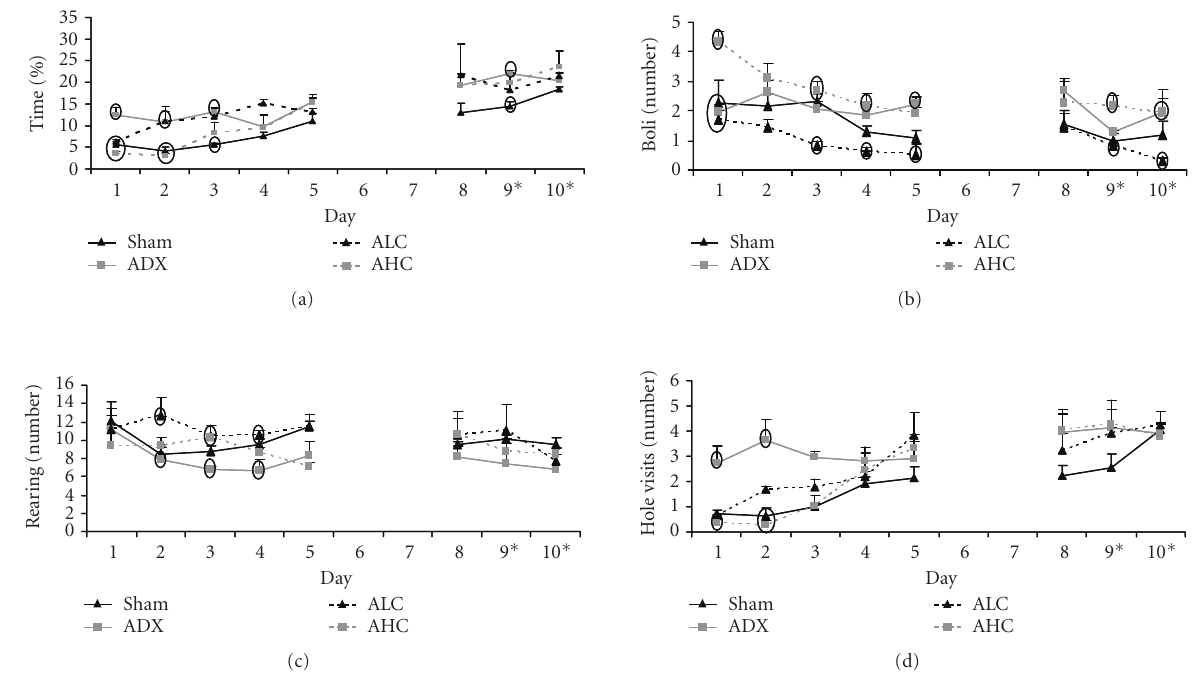
Figure 1: Behavior of mice in the modified hole board. (a) Percentage of time spent on center board, (b) number of defecations, (c) number of rearings, (D) number of hole visits, including revisits of sham (black line), ADX (grey line), ALC (striped black line), and AHC mice (striped grey line). Days 9 and 10 on the x -axis indicate removal of rings from all cylinders, while the bait remained in the same cylinders as before. Data present the mean of the three trials per day ± SEM. Ovals mark data points with significant di ff erences P < . 05 between groups within